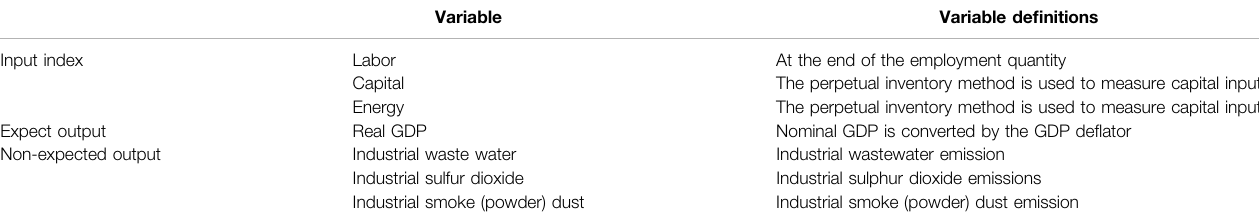
TABLE 5 | Green economic growth ef fi ciency of input and output